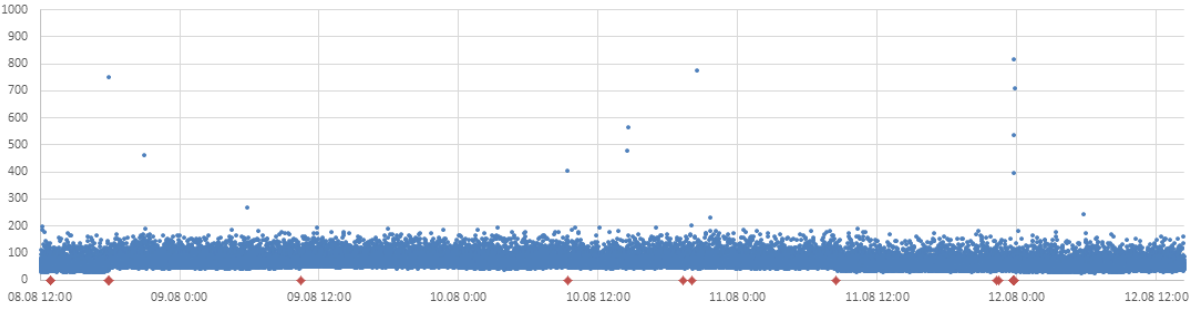
Fig. 10. RTT of lightly loaded LMT 3G second endpoint (Google free DNS),